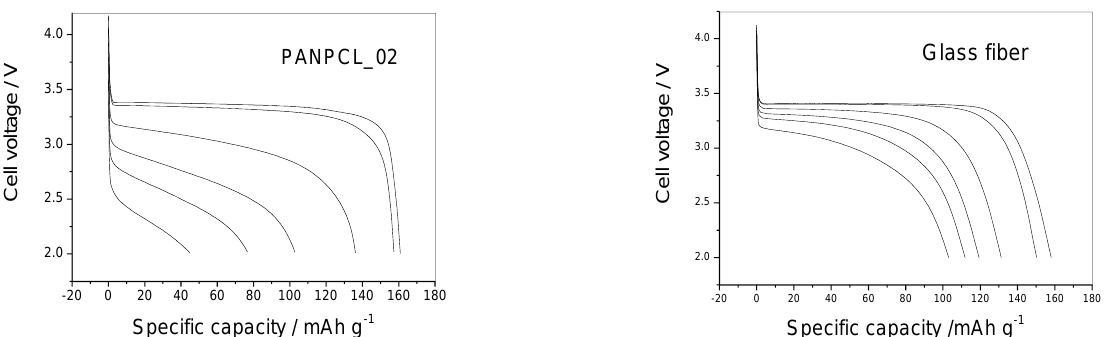
Figure 9. Voltage profiles as a function of the specific capacity for a cell made with the PANPCL_02 separator ( left ) and one made with the glass fiber separator ( right ) when cycled at various discharge rate (0.1 C, 0.2 C, 1.0 C, 2.0 C, 3.0 C, and 5.0 C).